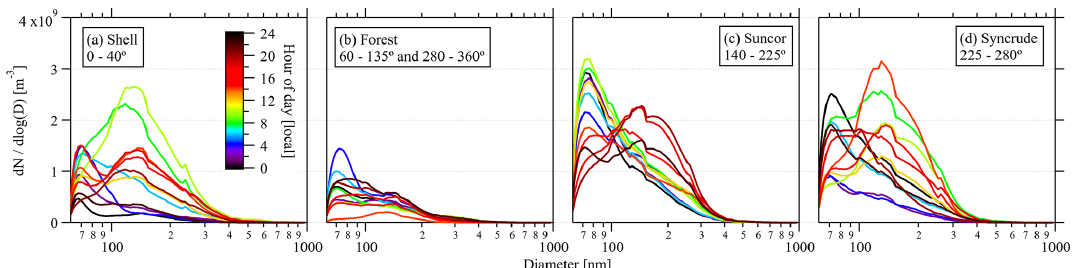
Figure 3. Number particle size distributions (PSDs) by time of day (averaged over 2h) for the four sectors identified in Fig. 2 (with the two forest sectors combined).